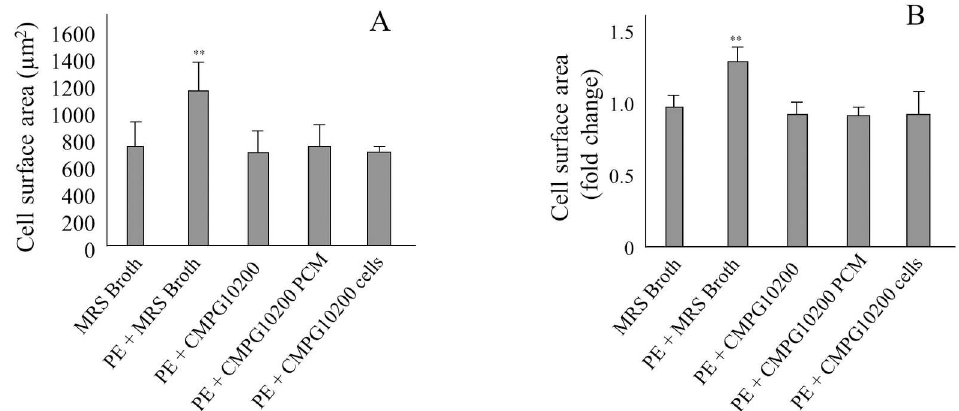
Fig 4. L . rhamnosus GR-1 MSP-1 knock out strain CMPG10200 inhibits PE-induced hypertrophy in NVCM. A. The NVCM surface area following24 hour co-culture with CMPG10200 (n = 5). B. The fold change in NVCM surface area comparedto untreatedcells, following24 hour co-culture with CMPG10200 (n = 5). All volumes of CMPG treatments were 50 μ L (1 x 10 9 CFU/mL stock culture). ** P < 0.01compared to all other treatments. Error bars indicate the standard